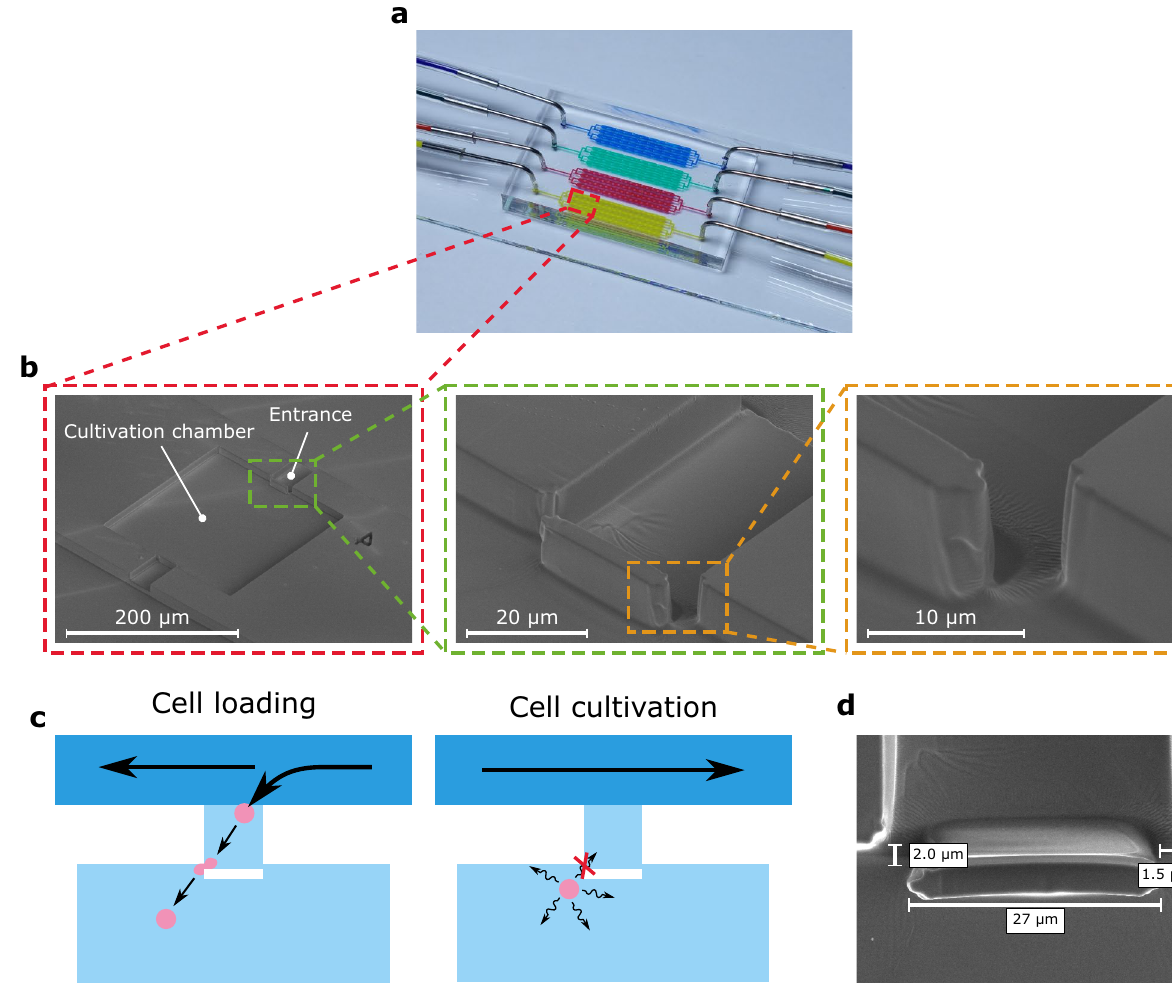
Figure 1. Structure and cell retention concept of the MSCC device with enhanced cell retention for CHO suspension cell lines. ( a ) Microfluidic PDMS-glass-based cultivation device. ( b ) Scanning electron microscopy image of the microfluidic structure illustrating the devices dimensions and trapping barrier. ( c ) Schematic drawing of the loading procedure and cell retention concept based on a PDMS barrier that is traversable by applying pressure during cell loading but non-traversable by random cellular movement during cultivation. ( d ) Scanning electron microscopy image of the PDMS barrier located in the cultivation chamber’s